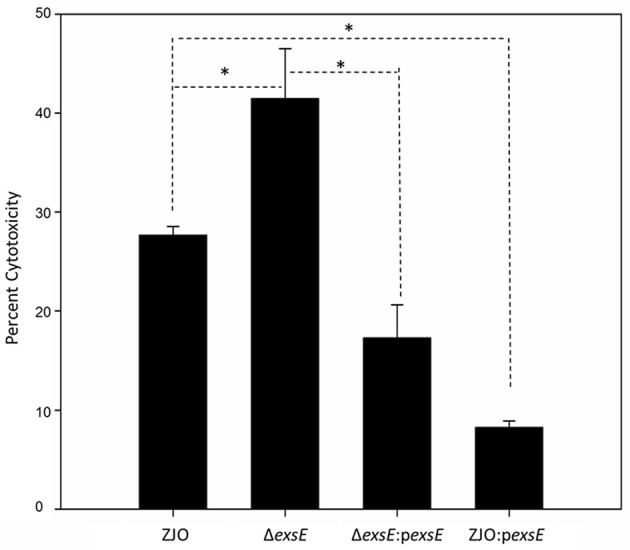
ExsE exerts a negative regulatory effect on in vitro cytotoxicity. LDH assay 1.5 h post infection. Deletion of exsE in V. alginolyticus led to increased T3SS-induced cell death while intrans expression of exsE inhibited cytotoxicity in the wild-type strain. Asterisk represents statistical significance (P < 0.05). Error bars represent SEM (n = three independent replicates).